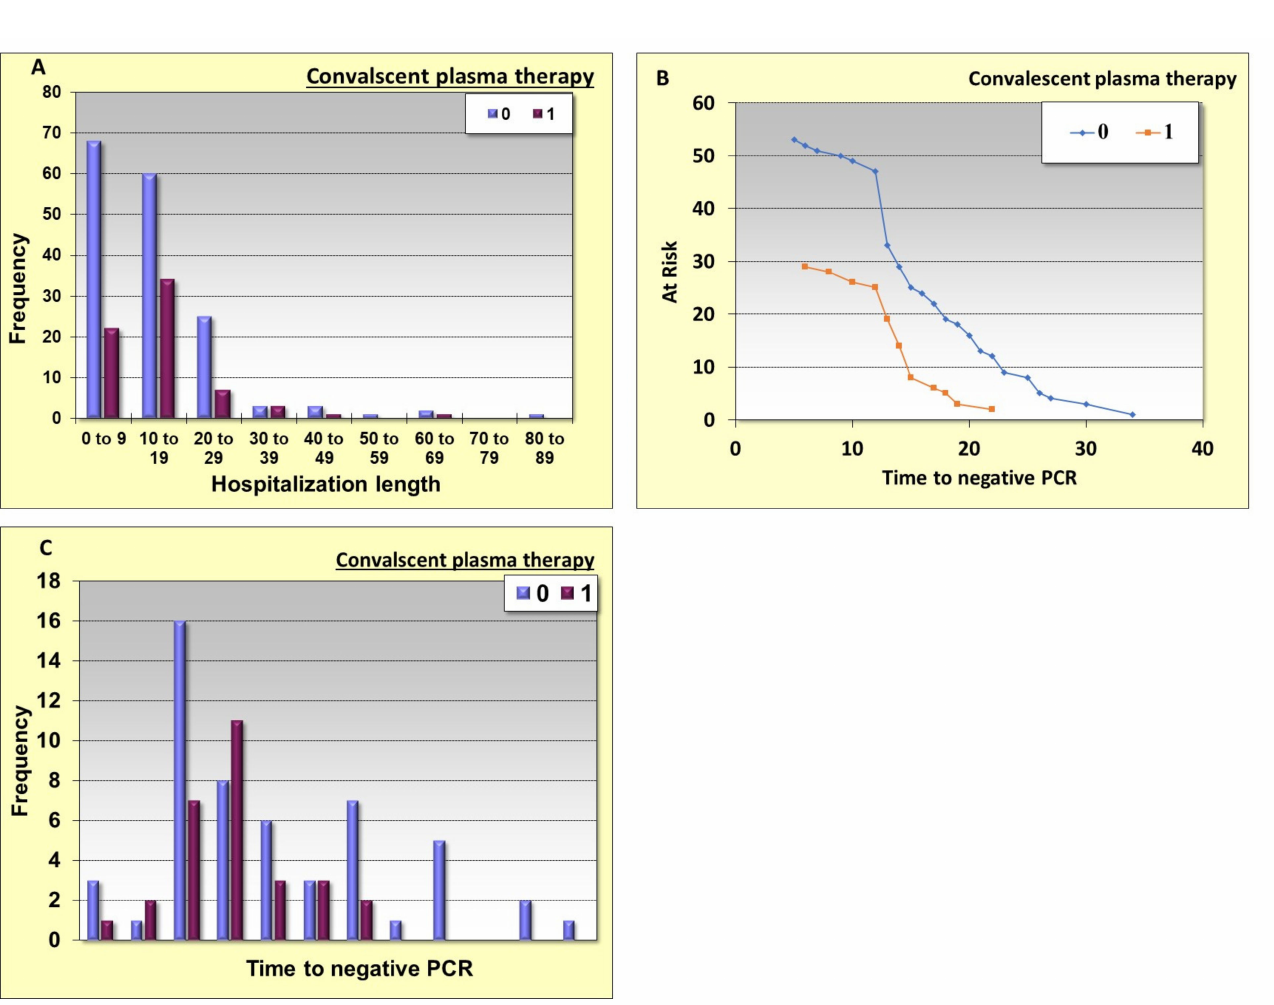
Figure 1. The effect of convalescent plasma on hospitalization length and time to negative PCR. ( A ): The frequency of patients in different categories of hospitalization length. ( B , C ): Correlations between convalescent plasma and time to negative PCR. The 0,1 (blue and red columns) are the patients who were not treated with convalescent plasma and those treated with it, respectively. The time measured in days of